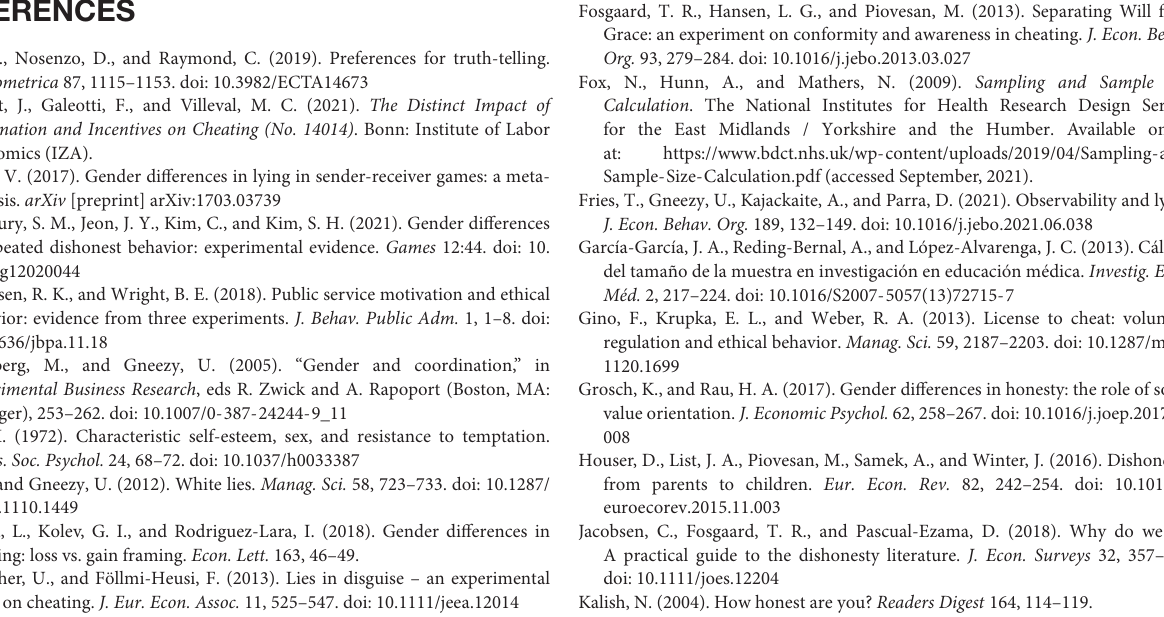
Supplementary Figure 1 | Real and declared rolls. Real rolls in the horizontal axis and declared roll in the vertical axis. Supplementary Figure 2 | Average report for different profiles (Maximizers report always the maximum outcome